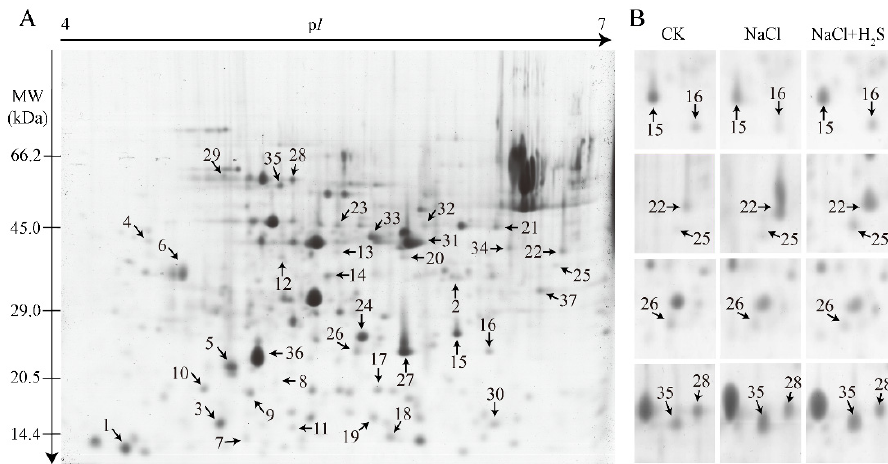
Figure 3. Two-dimensional (2-DE) analysis of proteins extracted from the leaves of K. obovata seedlings. The numbers assigned to the protein spots correspond to those listed in Table 1. ( A ) Representative coomassie brilliant blue-R250 (CBB-R250) stained 2D gel of total proteins extracted from K. obovata leaves under the control condition. Proteins (1.5 mg) were loaded onto the pH 4–7 gradient immobilized pH gradient (IPG) strip for the first-dimensional isoelectric focusing (IEF) and then separated in the second dimension on a 15% SDS-PAGE gel. The isoelectric point (pI) and molecular weight (MW) in kilodaltons are indicated on the top and left of the gel, respectively. Arrows indicate 37 spots with at least 2.0-fold changes ( p < 0.05) that were analyzed by matrix-assisted laser desorption/ionization time-of-flight mass spectrometry (MALDI TOF MS). ( B ) The enlarged windows of the representative protein spots with different expressions under both the NaCl treatment and the NaCl and H 2 S treatment. NaCl stands for the 400 mM of NaCl treatment, NaCl and H 2 S stands for the treatment with 400 mM of NaCl and 200 μ M NaHS, and CK stands for the control treated only by a 1/4 strength Hoagland solution.